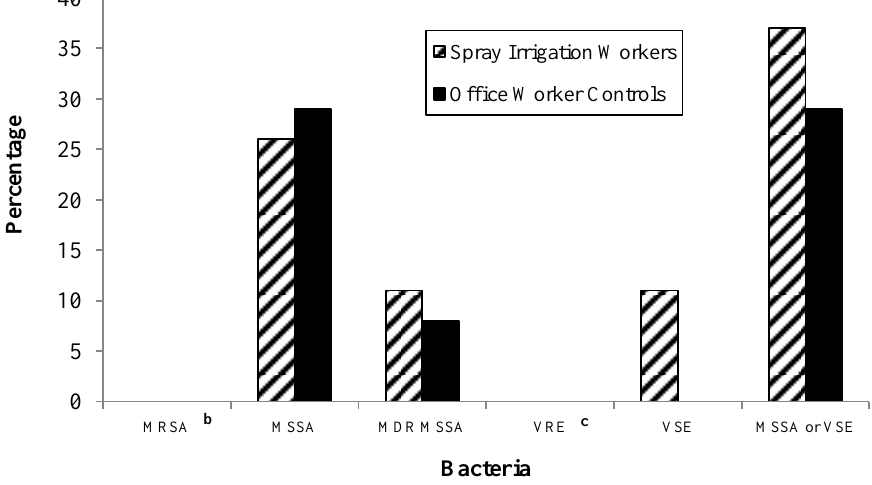
Figure 1. Prevalence of methicillin-resistant Staphylococcus aureus (MRSA), methicillin-susceptible S. aureus (MSSA), multidrug-resistant (MDR) MSSA, vancomycin-resistant enterococci (VRE), vancomycin-susceptible enterococci (VSE), and MSSA or VSE among spray irrigation workers (n = 19) and office worker controls (n = 24) a